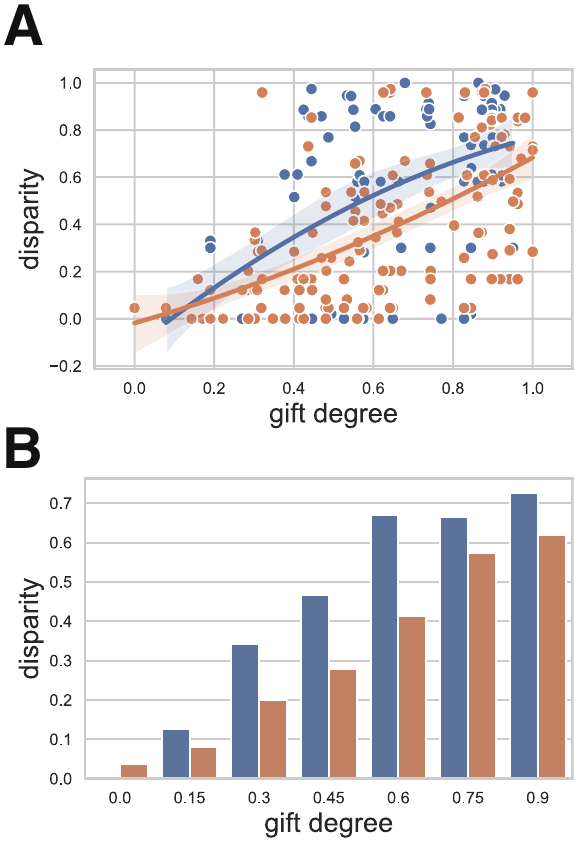
Fig. 4 Empirical relations between the gift degree and economic/social disparities. A Scatter plots of the relationships of economic (blue) and social (orange) disparities to the gift degree. The lines show a regression model of order 2 along with 95% con fi dence intervals. B Histogram corresponding to scatter plots.